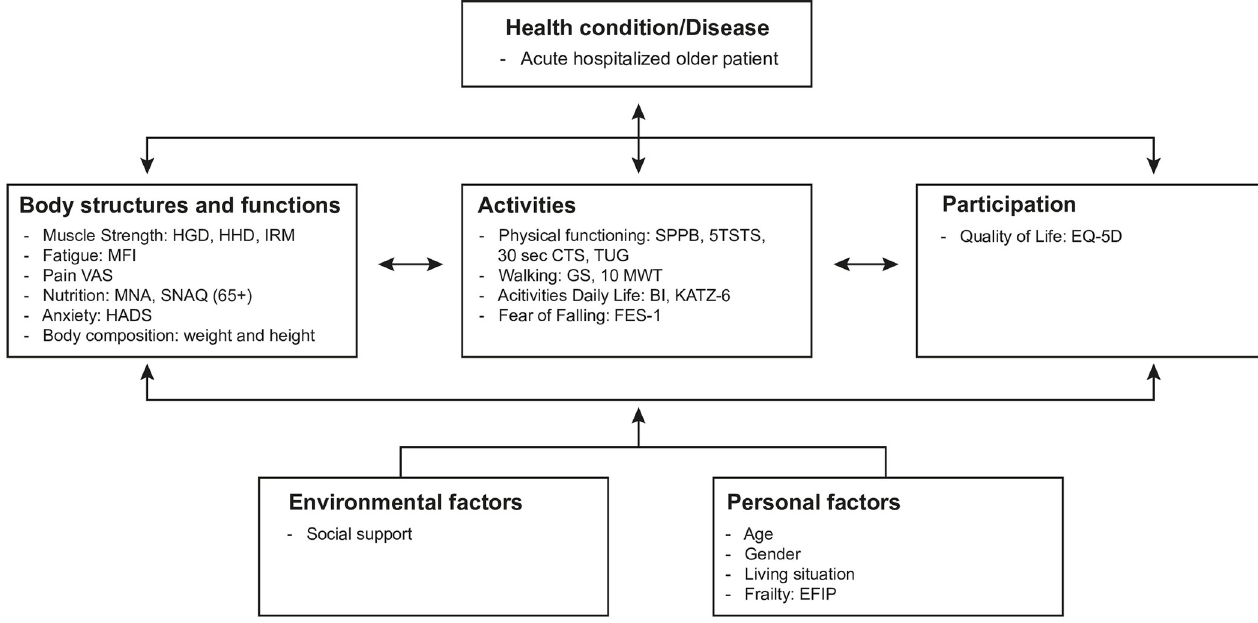
Fig 3. Core outcome set (COS) of measurement tools per ICF domain